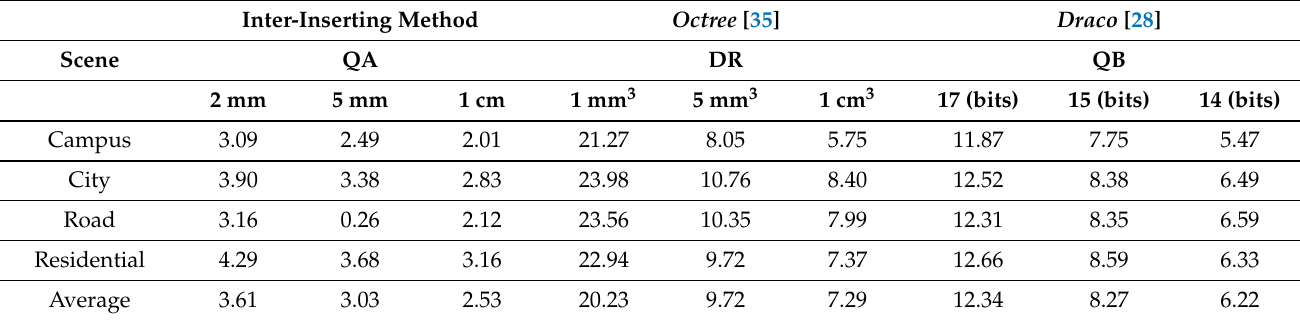
Table 1. Comparison ratio results with the Draco and Octree